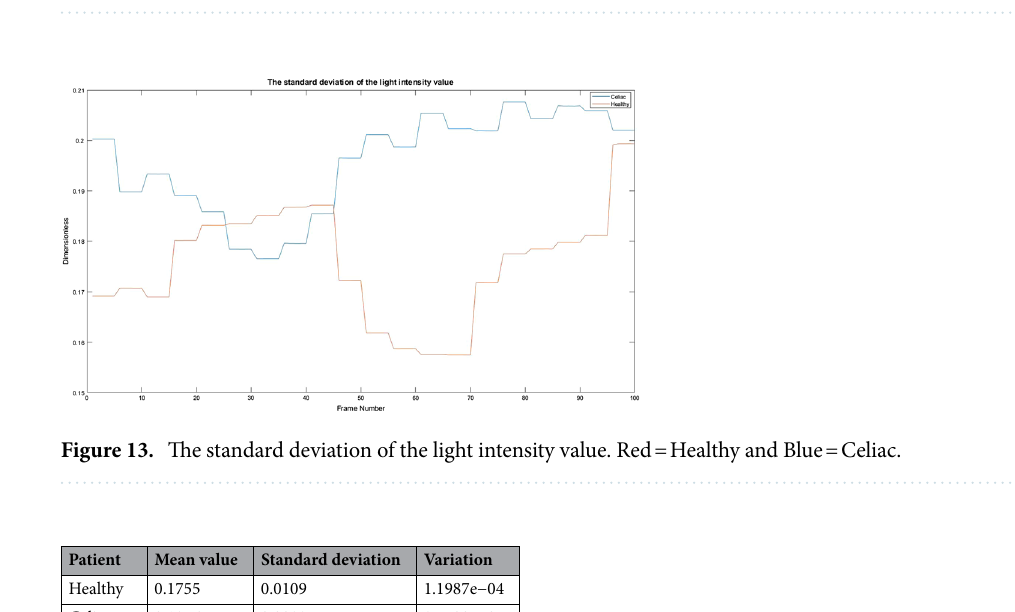
Table 3. Interpretation of the average variation of light intensity.